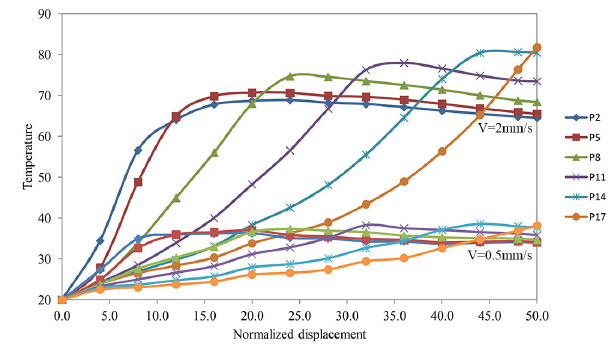
Figure 7: Temperature history versus normalized displacement in different material points for